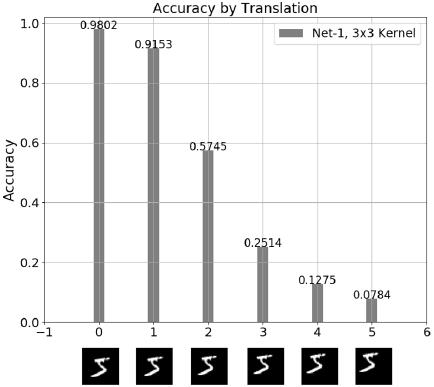
Figure 5. The test accuracy for the Net-1 network of 3 × 3 kernels trained with spatial images only. Even utilizing a deep network and a large receptive field, we obtained similar results. For deep networks, we trained the Net-K network with 3x3 kernels by varying K from 1 to 17. For large receptive fields, we trained the Net-1 network of varying kernel sizes from 3 × 3 to 37 × 37. The receptive fields of the network cover the entire image at 17 layers and 37 kernel size, respectively. Only 2-pixel translation (green line) significantly decreases accuracy regardless of the larger number of layers or larger kernel size as shown in Figure 6.